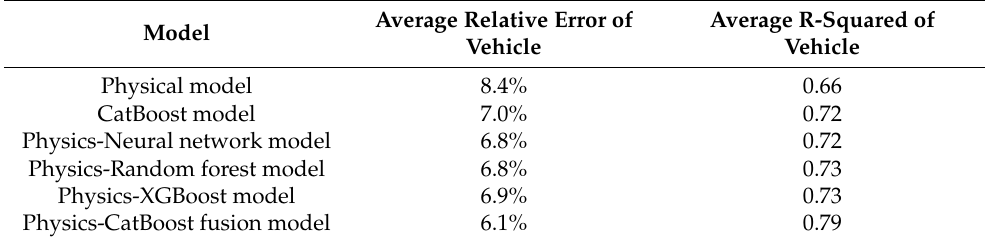
Table 4. Vehicle energy consumption estimation results with different models. Average Relative Error of Model